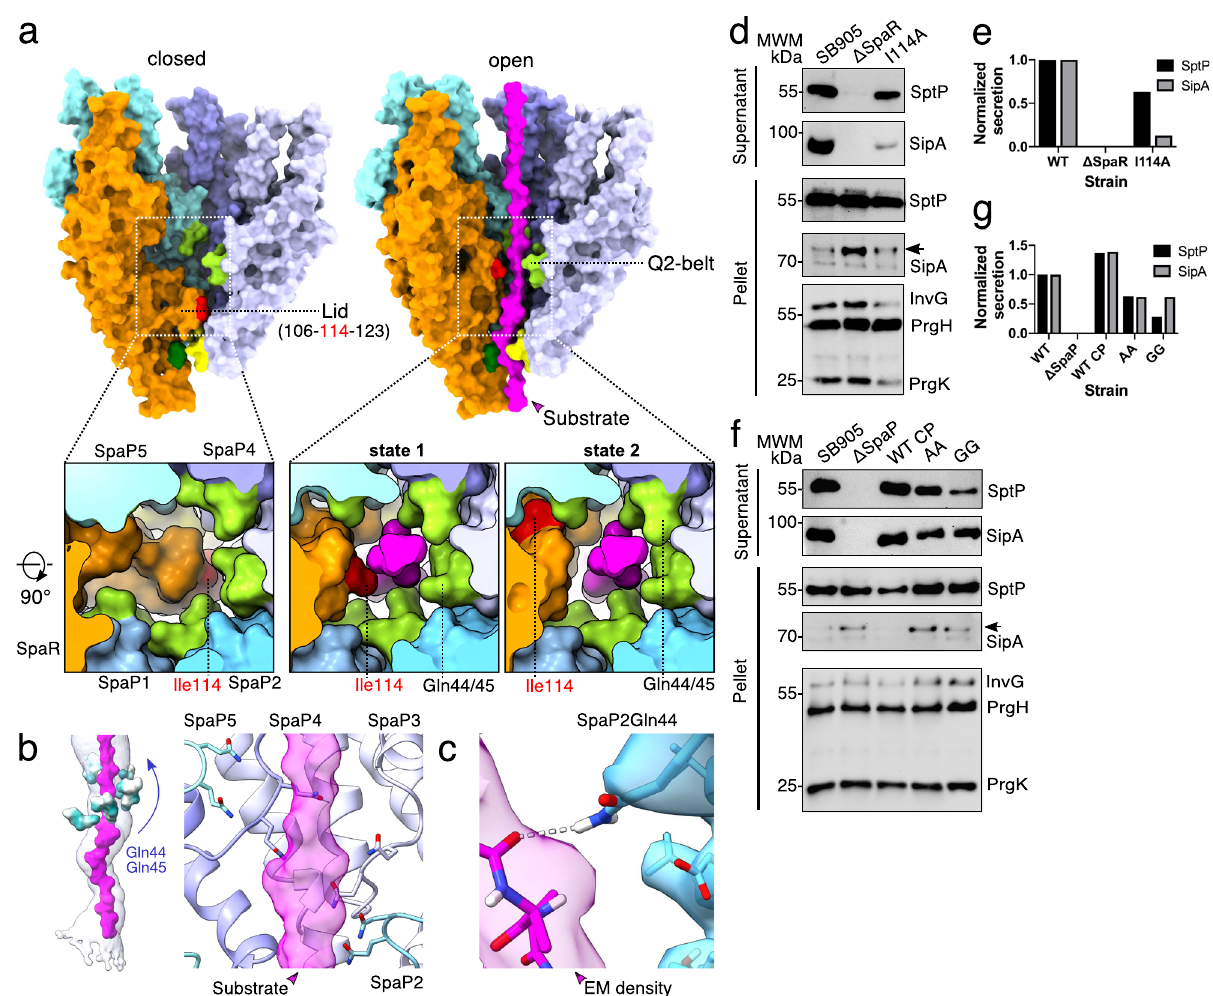
Fig. 5 Conserved glutamines in SpaP and the SpaR lid together orchestrate substrate transport through the Q2-belt of the EA. a Surface representations of the EA showing the SpaR loop/lid and surrounding Q2-belt. Q2-belt residues are shown in light green, M-gate residues in yellow. Numbers correspond to residues building the SpaR lid. Phe212 and Ile114 are displayed in dark green and red, respectively. b Left: surface representations of the Q2-belt residues Gln44/45 colored by hydrophobicity. Right: close up of Q2-belt with Gln44/45 displayed in stick representation and SpaPs as ribbon diagrams. c Hydrogen-bond formation between the substrate backbone and SpaP 2 Gln45. The surfaces represent EM density (threshold: 0.016). d Representative immunoblots of three independent secretion assays of SptP and SipA effector proteins using wild-type SB905, SpaR knockout ( Δ SpaR), and a strain carrying the SpaR loop mutation I114A. e Densitometry quanti fi cation of SipA and SptP secretion assay immunoblots in d . f Representative immunoblots of three independent secretion assays of SptP and SipA effector proteins using wild-type SB905, SpaP-knockout ( Δ SpaP), and Δ SpaP strains reconstituted with either wild-type SpaP (WT CP), or the indicated SpaP Q2-belt Gln44,45 mutants. g Densitometry quanti fi cation of SipA and